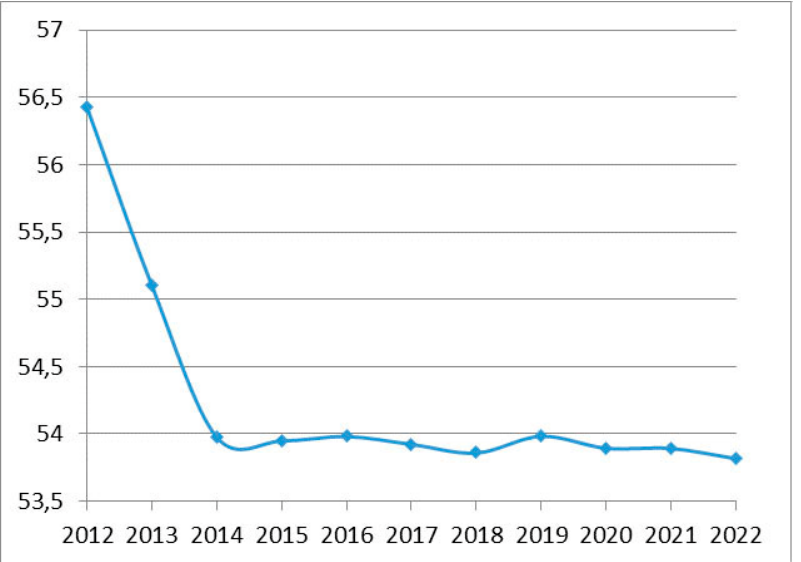
Figure 3. Modeled strategic values of commission income share in net income, % (developed by authors V.V. Manuylenko, A.I. Borlakova). authors V.V. Manuylenko, A.I.